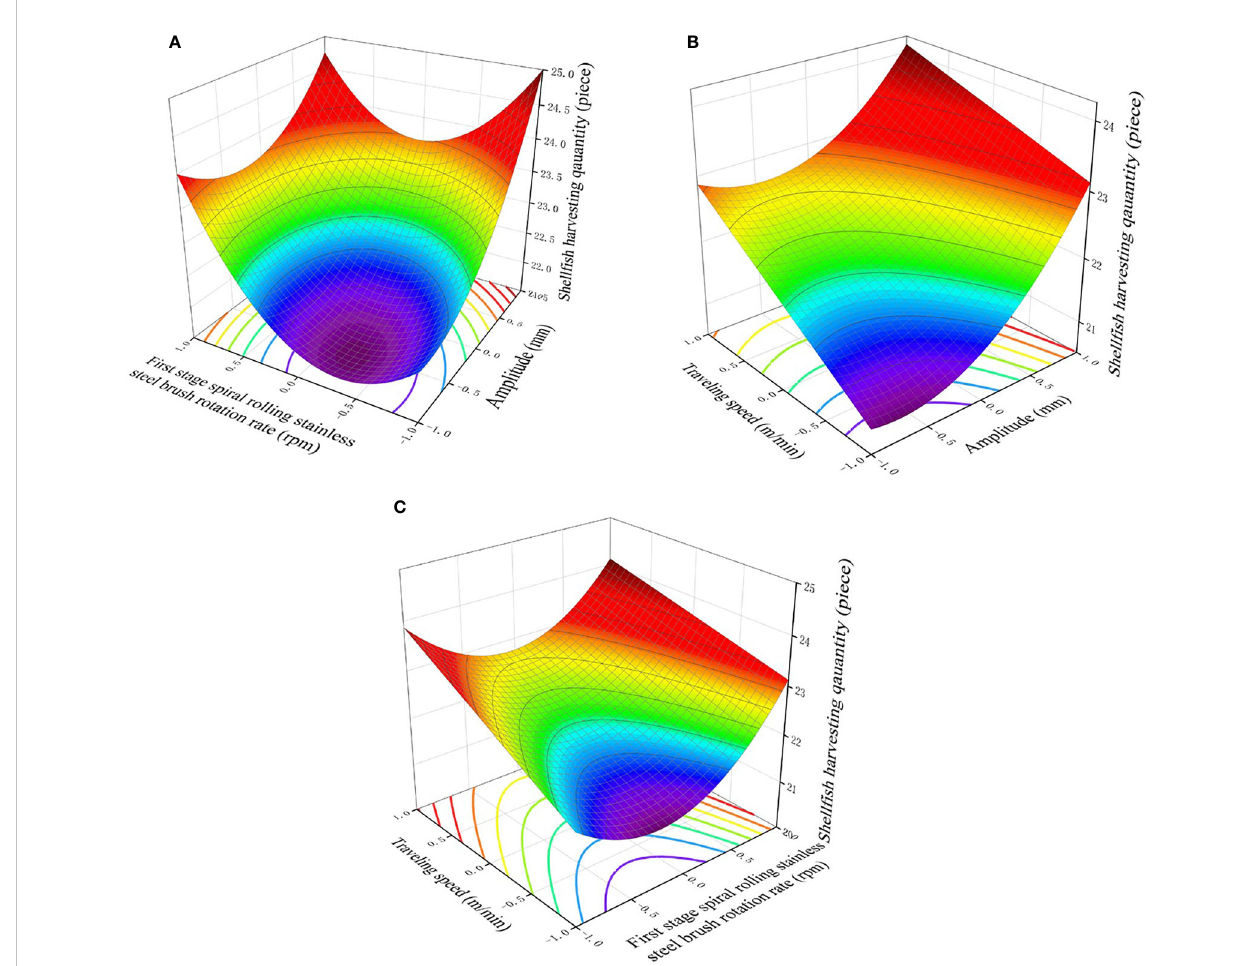
FIGURE 9 In fl uence of test factors on the quantity of shell fi sh harvested: (A) effect of fi rst-stage brush rotation rate and amplitude on the number of shell fi sh, (B) effect of amplitude and travel speed on the number of shell fi sh, (C) effect of fi rst-stage brush rotation rate and travel speed on the number of shell fi